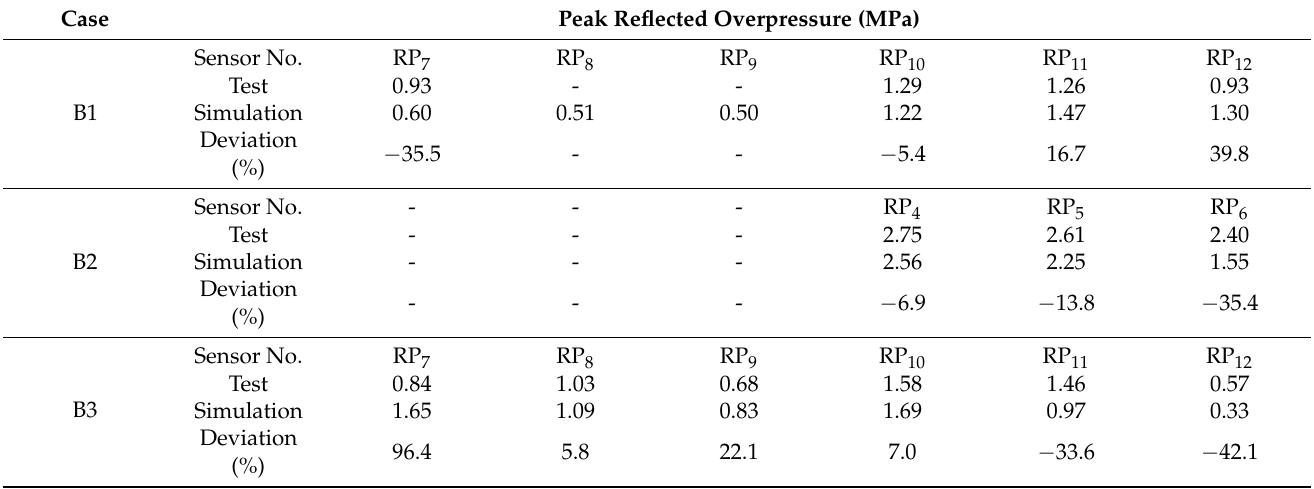
Table 8. Comparison of the reflected overpressure and acceleration between the test and simulation. Figure 8. Time histories of reflected overpressure: ( a ) and ( b ) Case B1; ( c ) Case B2; ( d ) and ( e )Case B3. Case